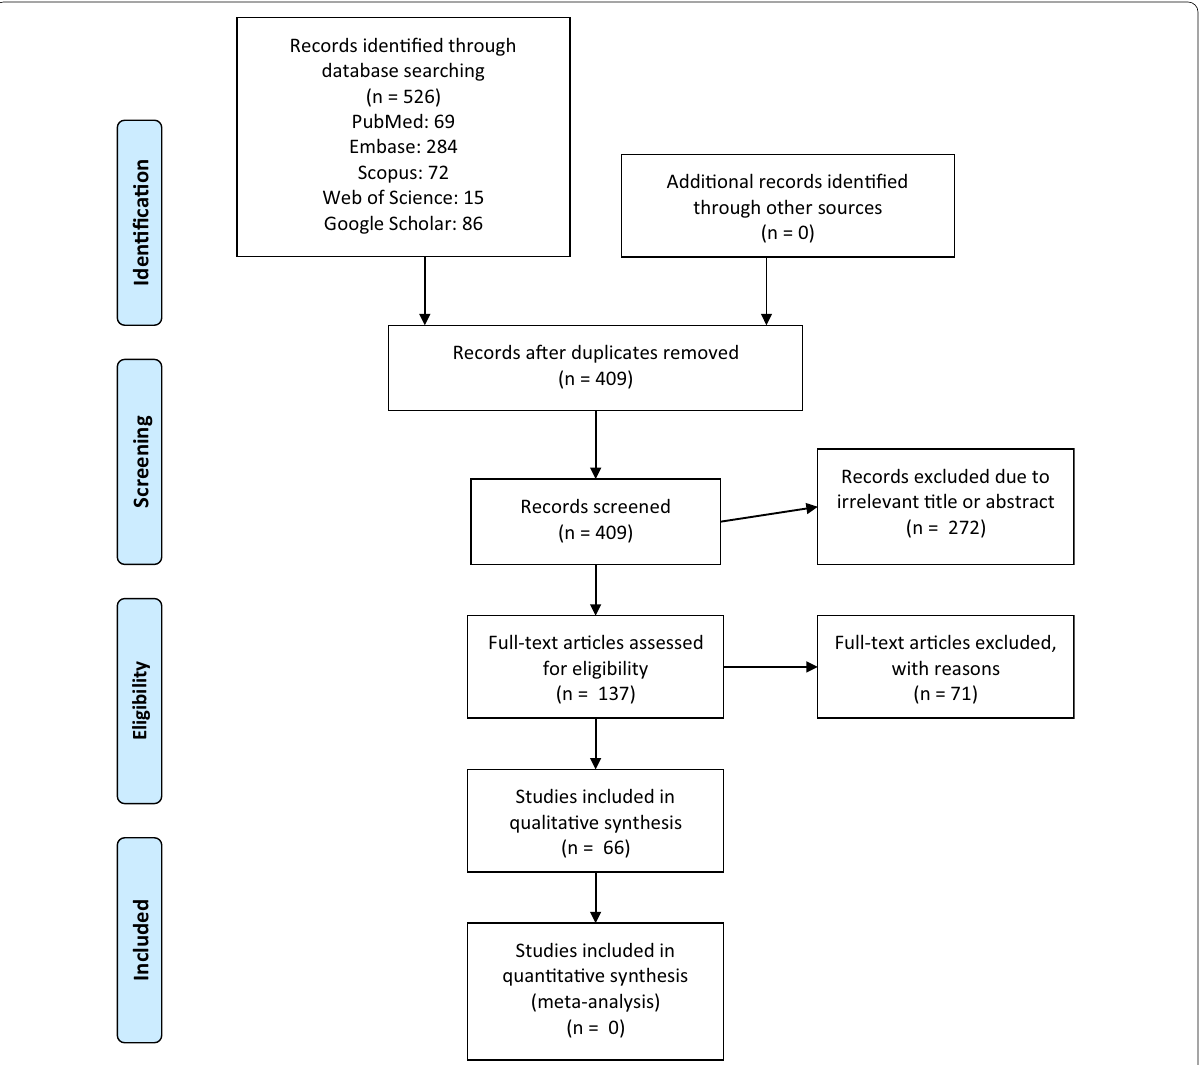
Fig. 1 Search results and selection of studies for systematic review according to the PRISMA